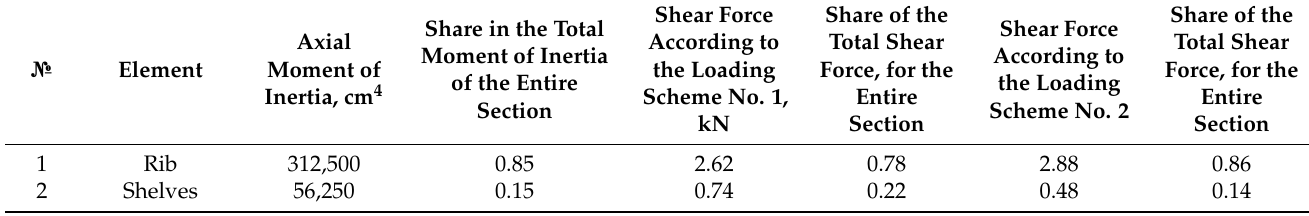
Table 2. Summary table of calculation results.